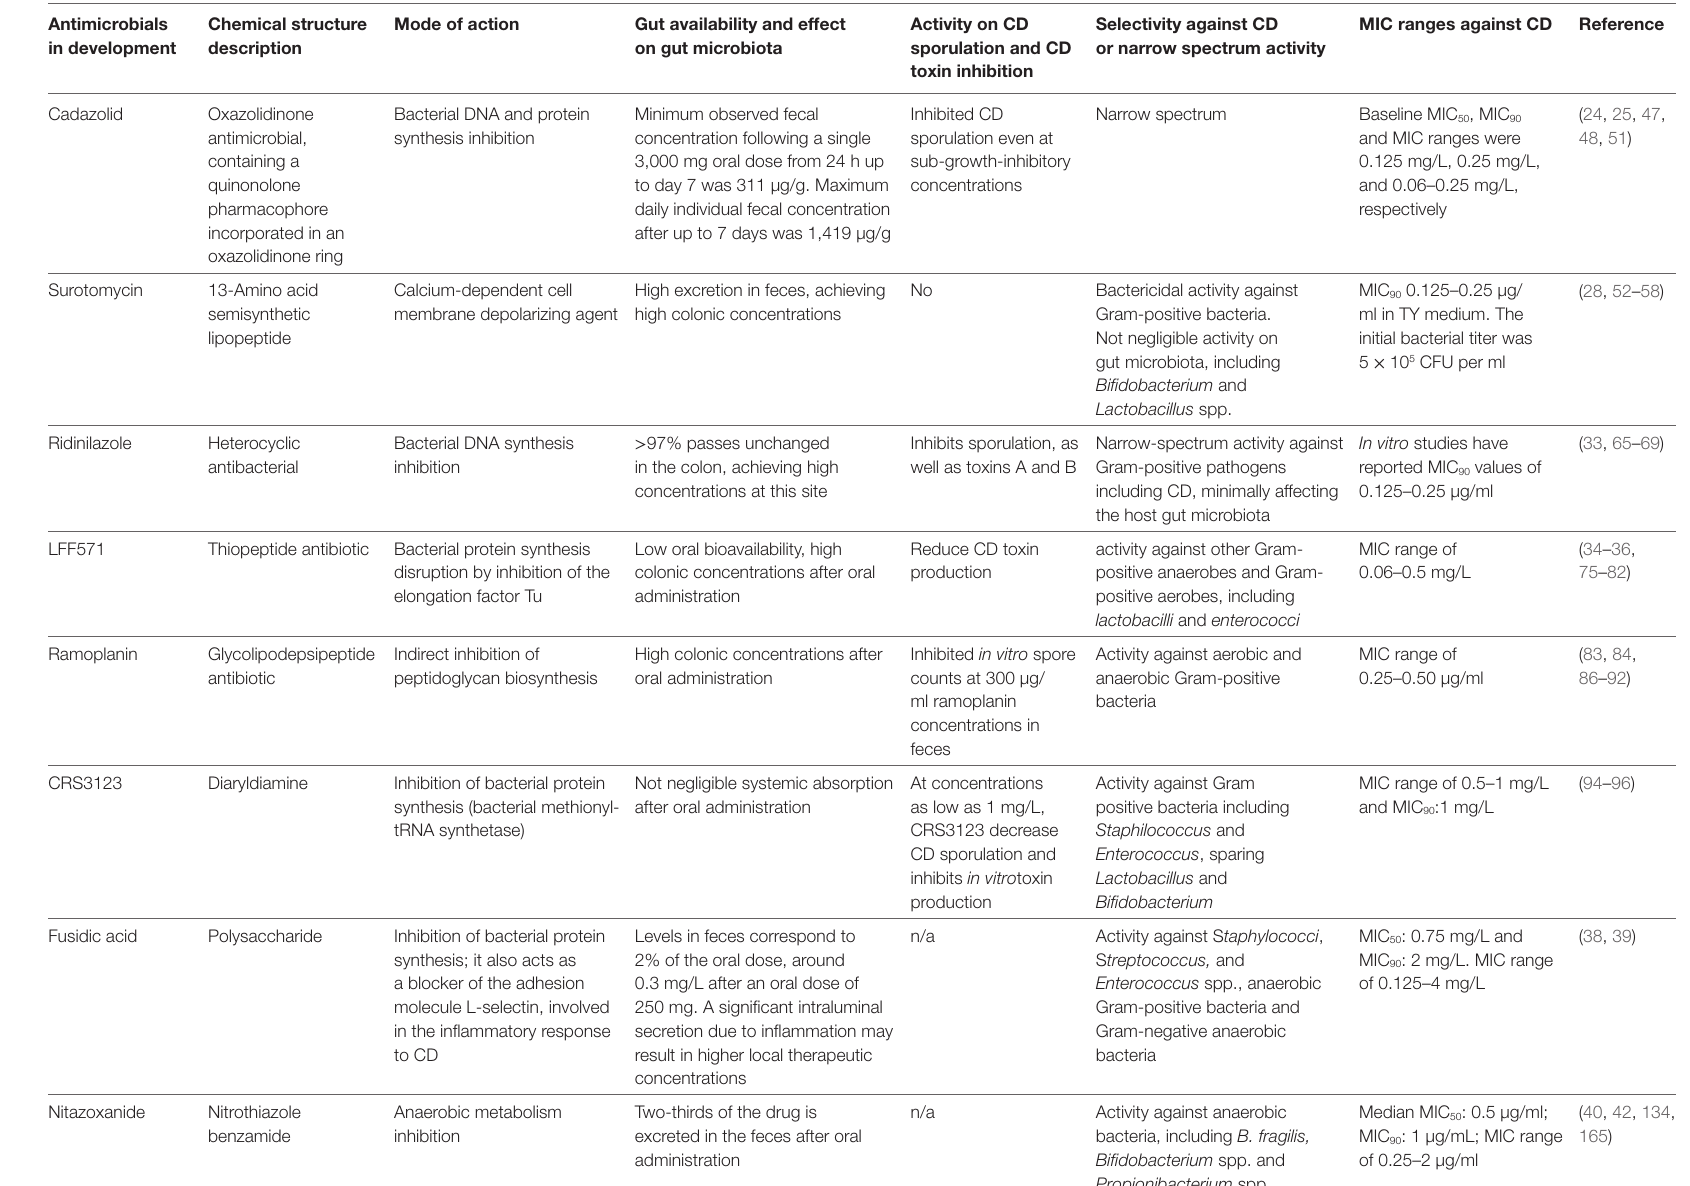
TAbLe 1 | Main characteristics and activity on CD spore and toxins production of the novel antimicrobials in development for CD. Antimicrobials in